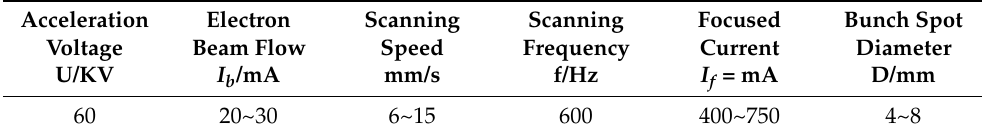
Table 3. Process parameter ranges for electron beam cladding of Ni60.